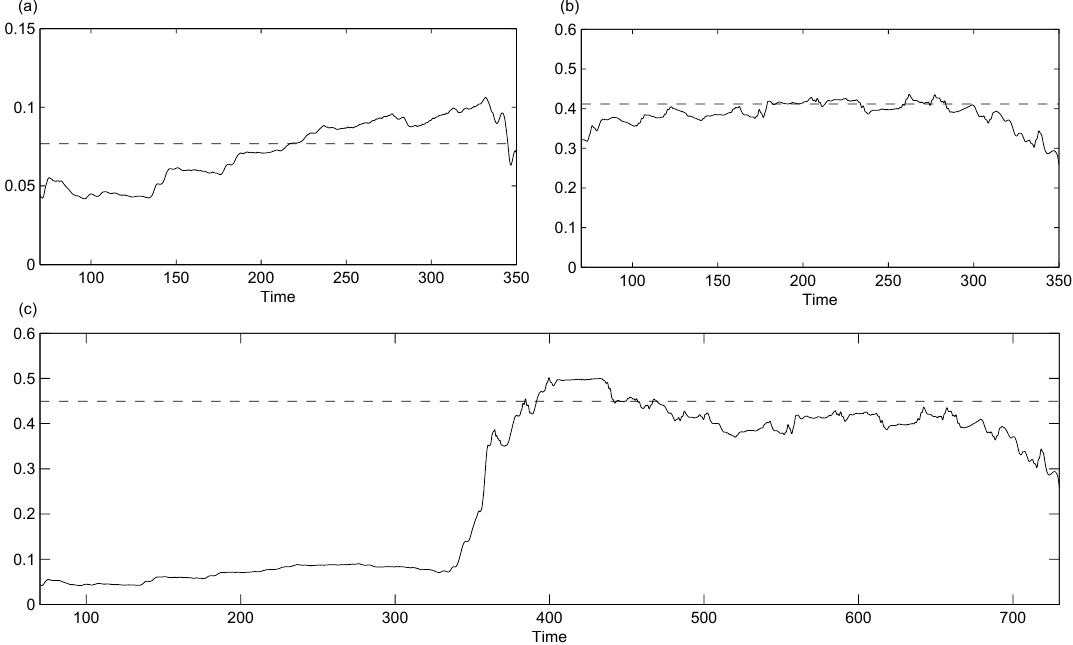
Figure 5. Windowed scale indices of series 1, 2 and 3 (see ( a ), ( b ) and ( c ) respectively), centered at different times with time radius τ = 50. The scale parameters run from s 0 = 0.05 to s 1 = 6.4 and we use Daubechies eight–wavelet function. The corresponding global scale index is represented with a dashed line.